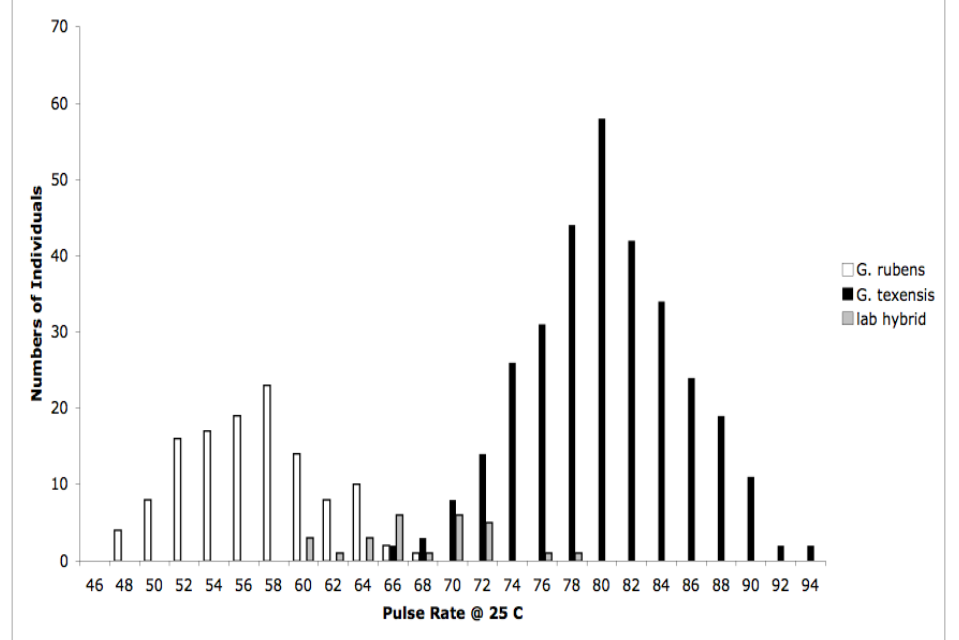
Figure 1. Pulse rates in the calling songs of males (corrected to a common temperature) are strongly bimodal and show almost no overlap; laboratory produced hybrids are